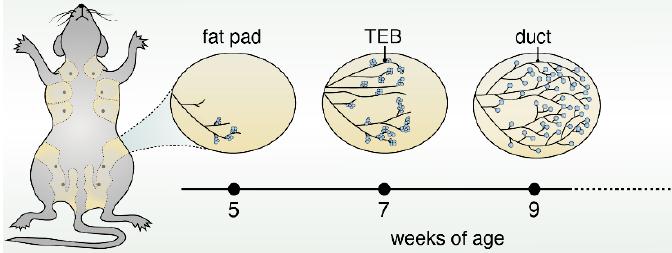
Figure 1. Schematic of mouse mammary gland development during puberty. During puberty, the rudimentary duct undergoes significant expansion, resulting in the formation of bulbous multilayered structures called terminal end buds (TEBs). These TEBs are the proliferative centers that drive elongation, bifurcation, and branching of ducts until the entirety of the mammary fat pad is filled, thereby creating the mature epithelial tree.